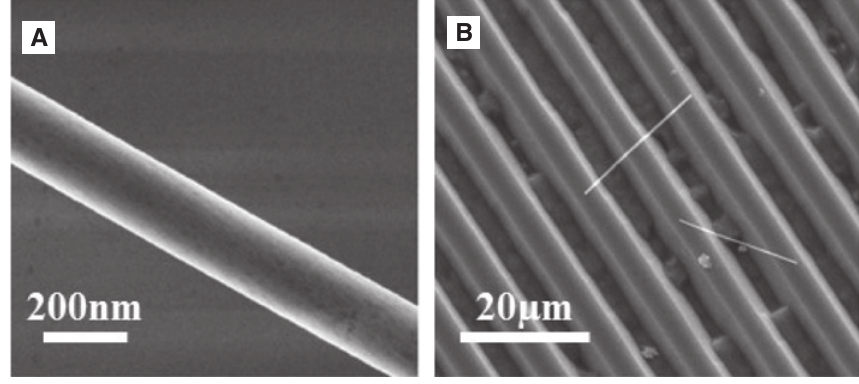
Figure 19: Single nanowire on a trench. (A) Smooth copper nanowire supported on flat silicon substrate. (B) Two nanowires crossing pyramidal trenches etched on the silicon